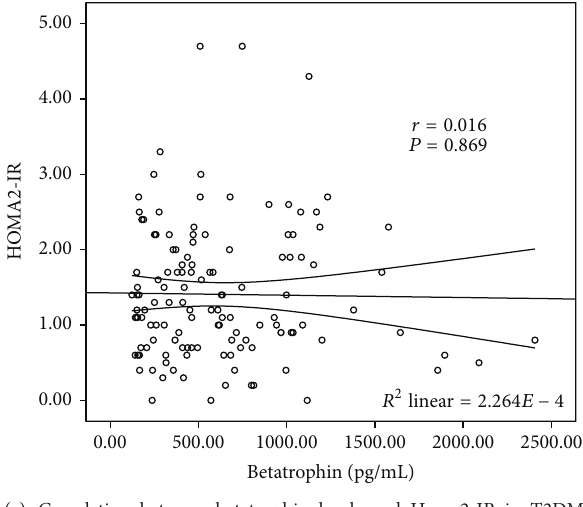
(c) Correlation between betatrophin levels and Homa2-IR in T2DM subjects Figure 1: Correlation between betatrophin levels and glucose-related variables in T2DM